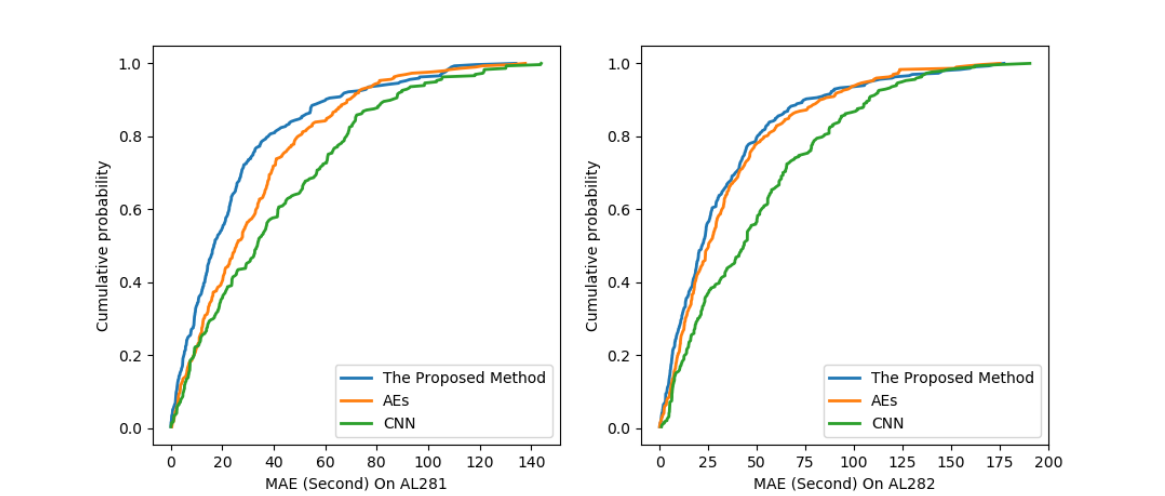
Figure 9. Cumulative distribution of the absolute predictive errors on link AL281 and link